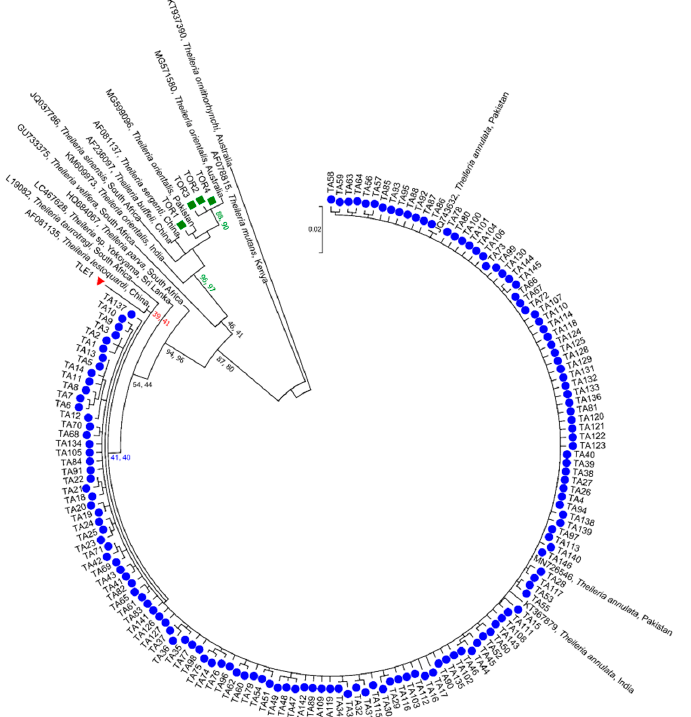
Figure 3. Phylogenetic relationships of amplicon sequence variants (ASVs) of Theileria species determined in this study (coloured symbols) with reference sequences from previous studies. The re- lationships were inferred based on separate analyses of 18S rRNA sequence data (aligned over 386 bp) using the Maximum Likelihood (ML) and Neighbor-Joining (NJ) methods. Theileria ornithorhynchi (KT937390) was used as an outgroup. Nodal support values are indicated as bootstrap values for the NJ (first) and ML (second) method. The scale bar indicates